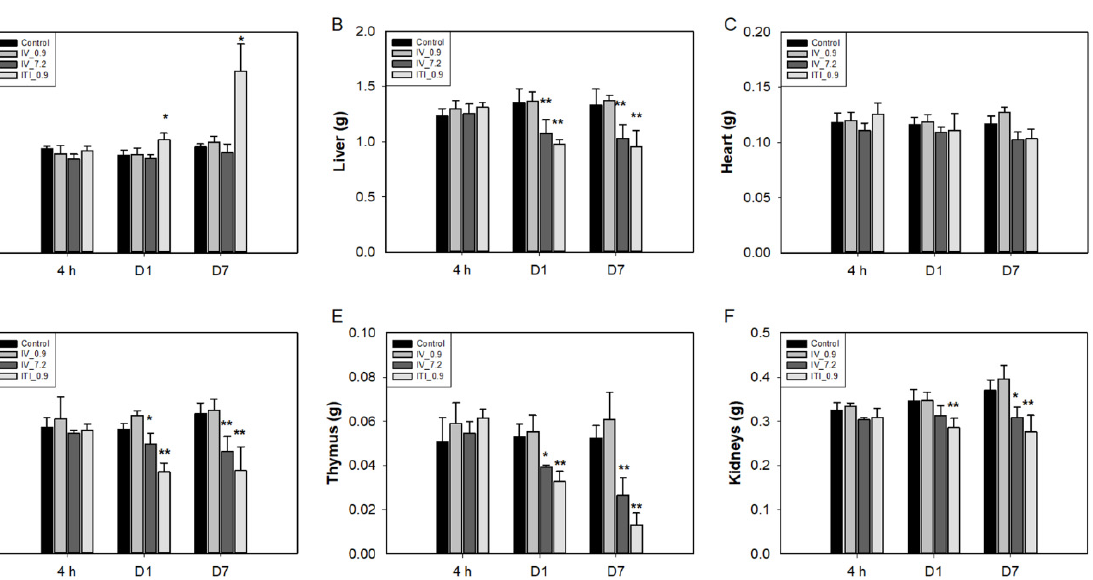
Table 1. Mean body weight of PHMG-P-treated mice.